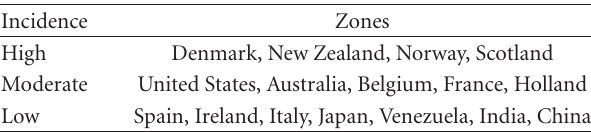
Table 2: Geographic distribution of RCC [8]. Incidence